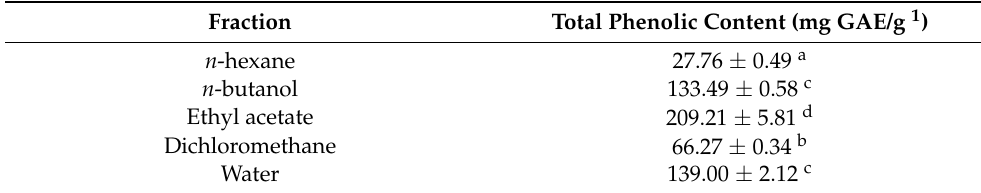
Table 1. Total phenolic contents of R. emodi fractions using the different solvents.